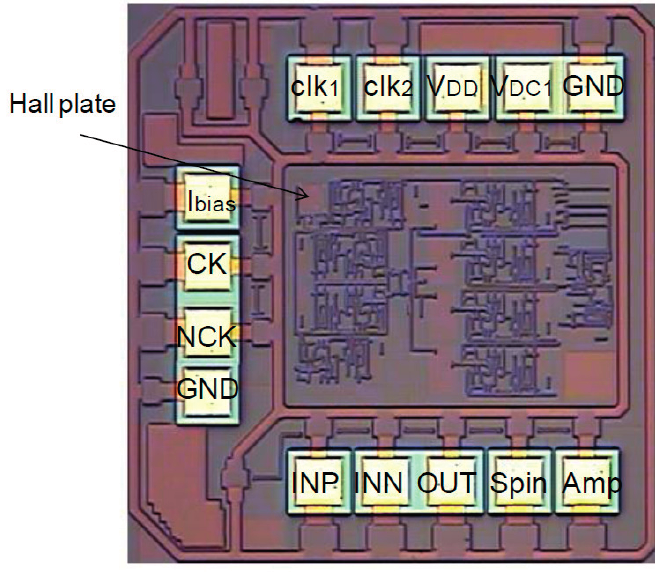
Figure 10. Micrograph of CMOS monolithic integrated Hall magnetic